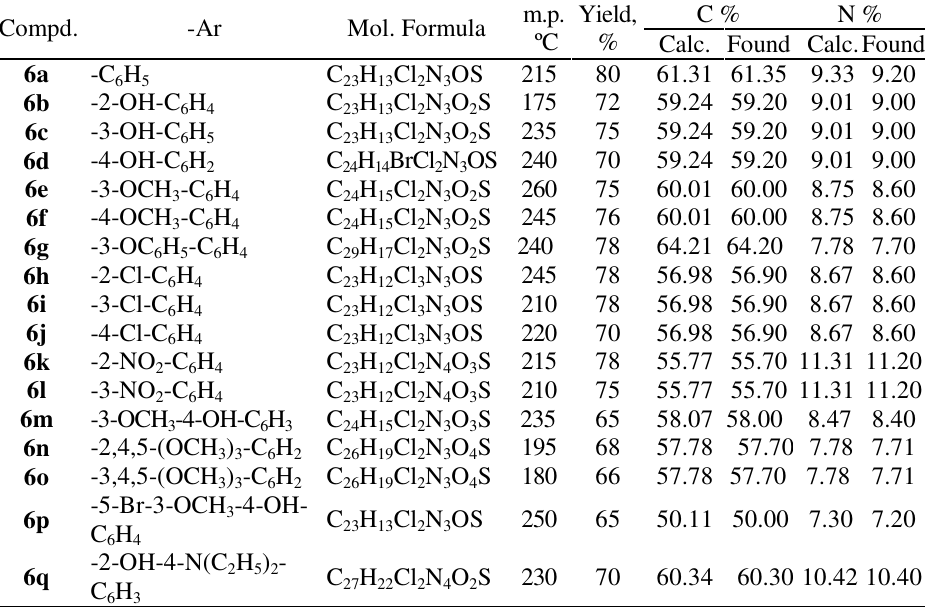
Table 1. Physical constant of the compounds